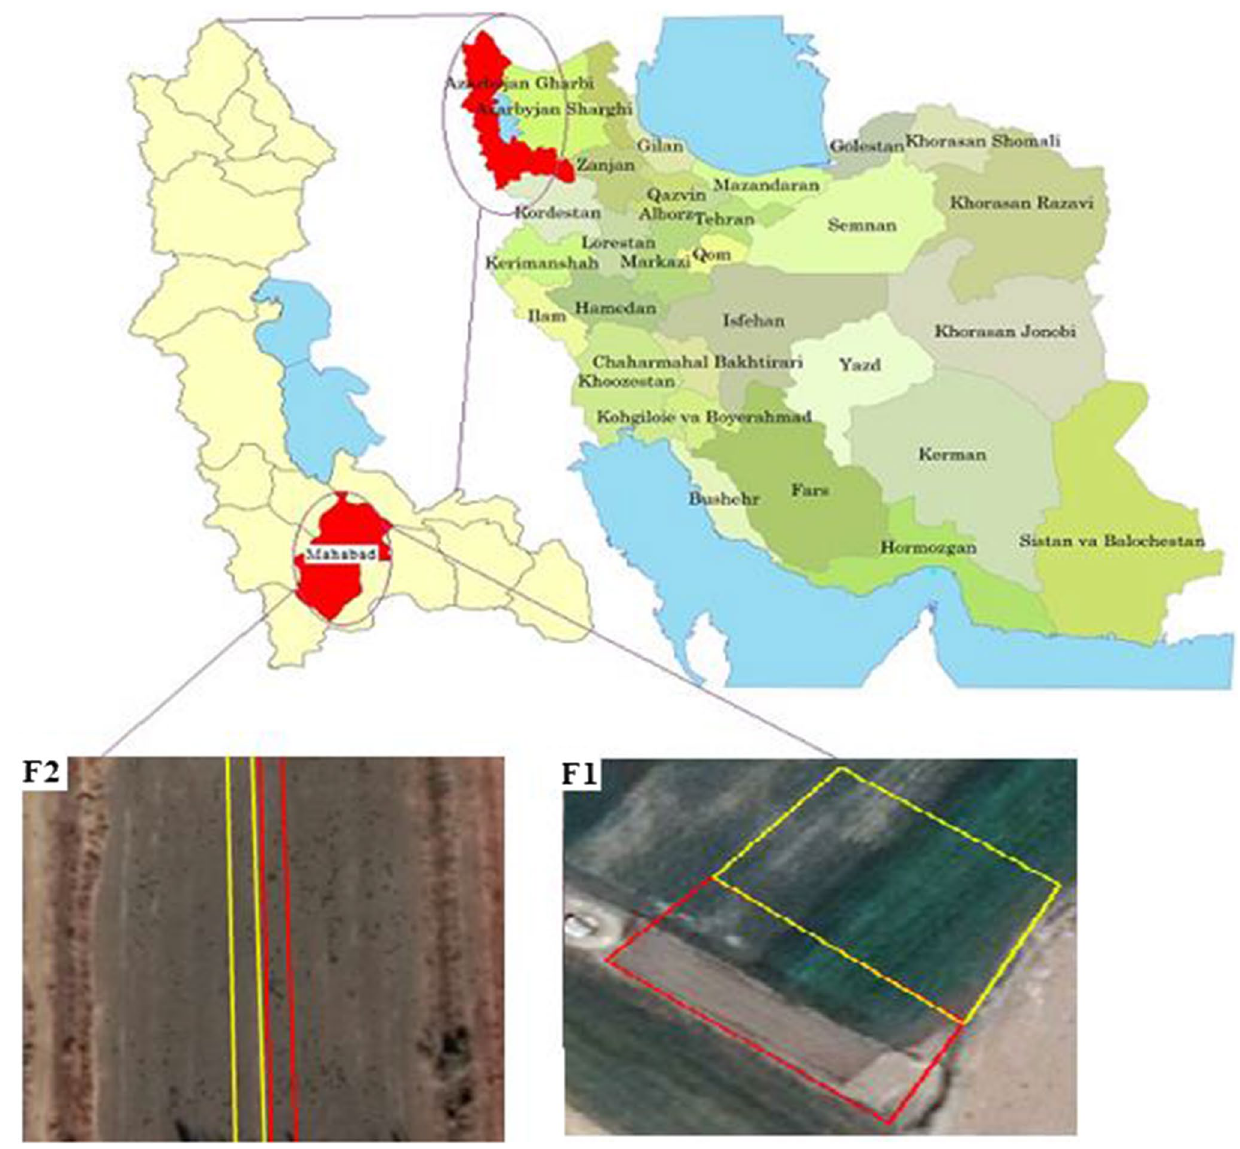
Fig. 1 Location of Mahabad plain and selected